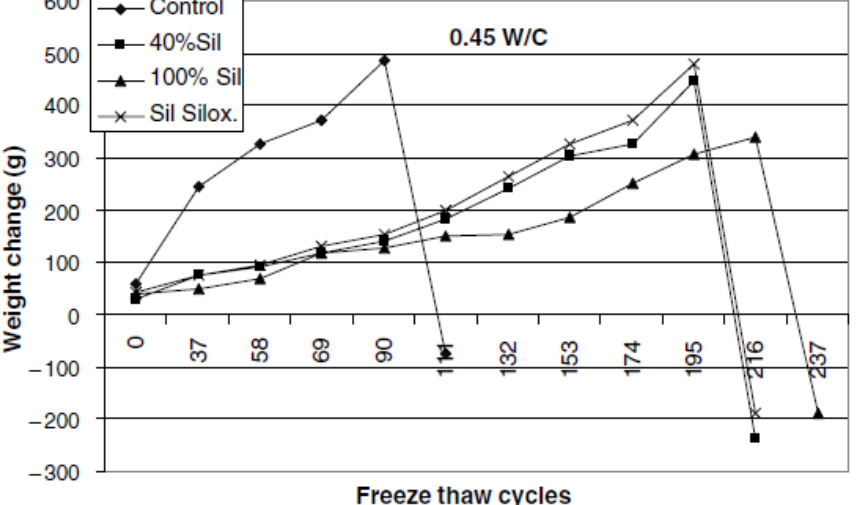
Figure 14. Effect of silane/siloxane pore liner on the freeze–thaw (FT) resistance of concrete specimens Figure 14. E ff ect of silane / siloxane pore liner on the freeze–thaw (FT) resistance of concrete specimens measured as weight changes upon a number of FT cycles [86]. measured as weight changes upon a number of FT cycles